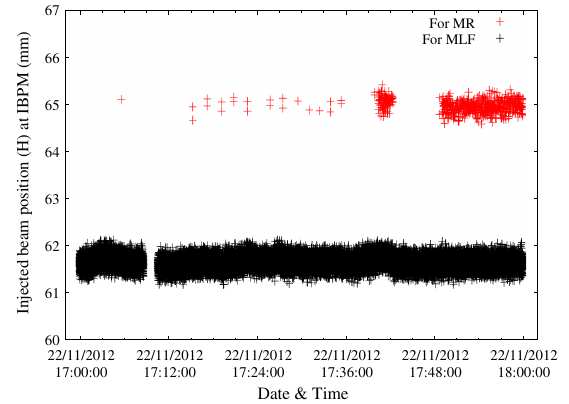
FIG. 11. An online trend of the horizontal injected beam position measured by the IBPM (see Fig. 3) for MLF (PSTR off) and MR (PSTR on) beam triggers during user operation of the RCS. The data taking period was about 1 h, while for the former half beam was delivered to the MR mostly by on demand single shot. The expected relative difference of the beam position is about 3 mm and was thus consistent with expectation. A good stability of the measured beam position for the MR reflects a good stability of the PSTR power supplies and eventually guarantees good control of the painting